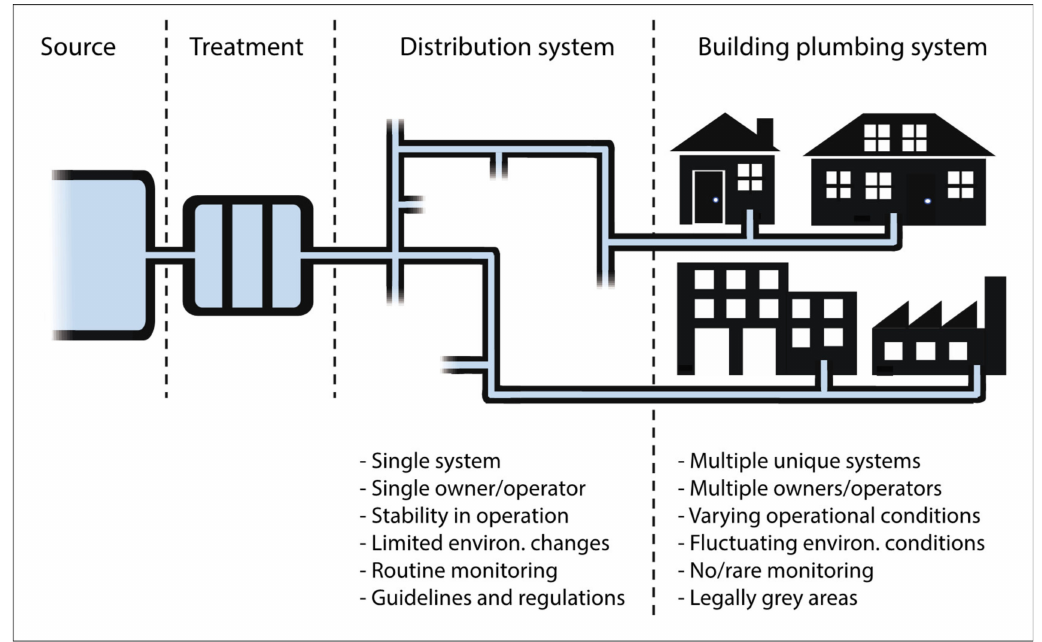
Figure 1. Drinking water from source to tap, highlighting key di ff erences between the main distribution system and building plumbing